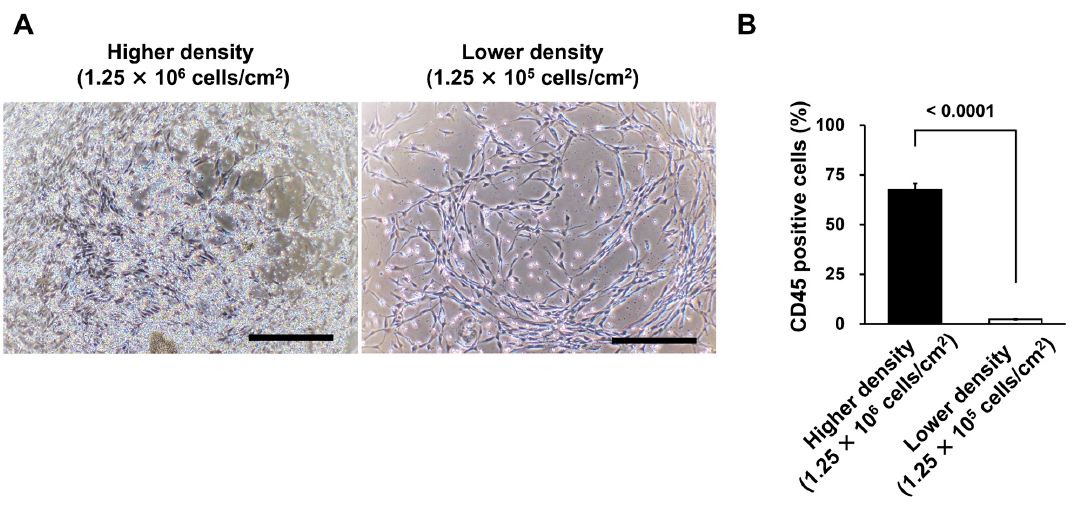
Figure 3. Different seeding densities of mononuclear cells (MNCs) result in different numbers of CD45-positive cells remaining. ( A ) When colonies formed, remaining hematopoietic cells were ob- served by phase-contrast microscopy when seeded at different seeding densities (1.25 × 10 5 cells/cm 2 and 1.25 × 10 6 cells/cm 2 ). The scale bar indicates 500 µm. ( B ) Data quantified as the percentage of CD45-positive cells using FACS analysis. The error bars indicate S.E. ( n = 5). p -values were calculated using the Student’s t -test.